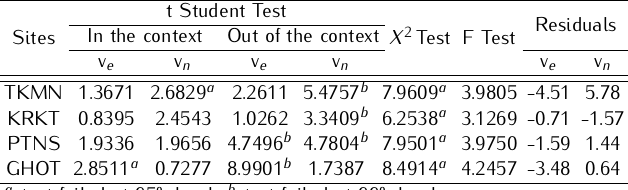
Table 7. Tests results (block B6). The results of the statistical tests for the GPS site data components. The sites passed from all the tests are the accepted data. The tests have been performed in two confidence levels (95% and